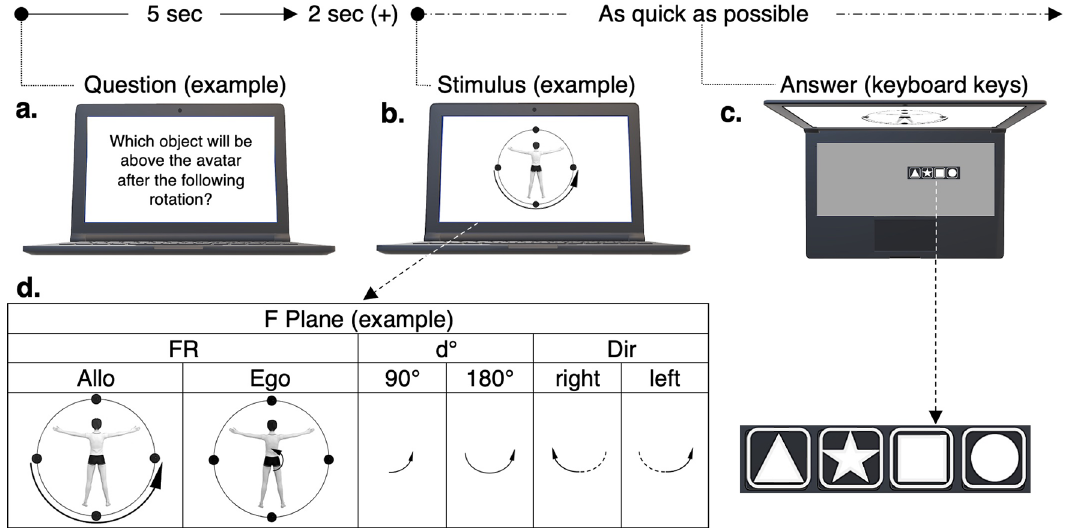
Figure 3. Design of the MRt (MR task) series: Example in F Plane (frontal plane). Each series was performed by using the same laptop, after a phase of familiarization. The subjects performed each MRt by identifying themselves with the avatar shown on the laptop screen, surrounded by a circle on which four black dots were placed to represent the arrangement of four objects that had been memorized during familiarization (a red triangle, a green star, a blue square, and a yellow disc). Before each MRt, a question was shown (for five sec), asking which object would be at a predetermined place relative to the avatar after a given MRt (Fig. 3a). The MRt was then defined by a graphical image (two sec after the question was removed) (Fig. 2b). Once seen the image, the subject answered as quickly as possible by pressing (with the dominant hand) one of four non-hidden keyboard keys that represented the four possible objects (Fig. 3c the objects on the keyboard-keys were the same as on the circle and were put in a clockwise order). The image defined the MRt by giving a set of instructions (Fig. 3d): ( a ) the circle surrounding the avatar indicated the plane of the MR to be done (Plane): either F (as in the example shown in Fig. 3d), the horizontal (H) plane, or the sagittal (S) one, ( b ) the curvilinear arrow placed on the image designated the frame of reference to be used: either allocentric (arrow outside of the circle; Allo), or egocentric (arrow on the avatar; Ego), ( c ) the shape of the arrow curve indicated the degrees of the MR (d°): either 90°, indicated by a quarter-circle, or 180°, indicated by a half-circle and ( d ) the tip of the arrow showed the direction (Dir) of the rotation: either rightward, or leftward in F and H, and either backward, or forward in S. As a consequence, in each Plane hence in each series of the MRt, eight variations of the task were performed (two FR conditions × two d° conditions × two Dir